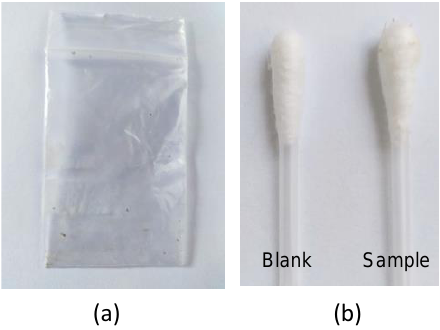
Figure 1. Images obtained in the studies for the analysis of residues of cannabis: ( a ) a plastic bag after the removal of the plant; ( b ) swabs after collecting the residue; and an unused swab (blank).